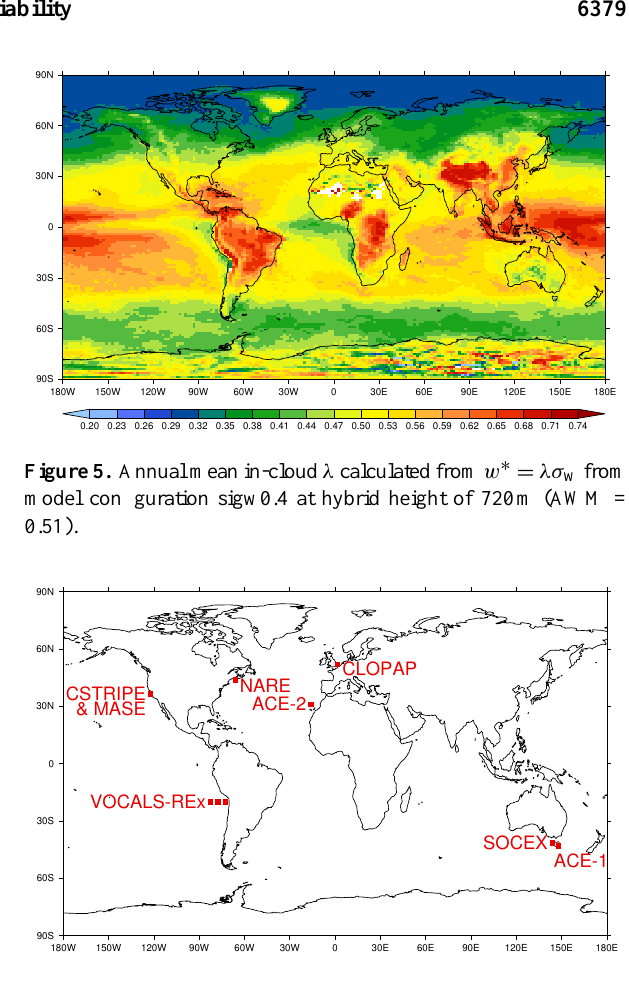
Figure 4. Annual mean in-cloud σ w and CDNC at 720m. Panels Fig. 4 : Annual mean in-cloud σ and CDNC at 720 m. Panels show differences between model w Figure 6. Map of flight campaign locations. Fig. 6 : Map of flight campaign locations. show differences between model configuration TKE_0.1 with re- configuration TKE_0.1 with respect to sigw0.4 for (a) in-cloud σ (AWM = − 0 . 15ms − 1 ) and w spect to sigw0.4 for (a) in-cloud σ w (AWM = − 0 . 15ms − 1 ) and (b) CDNC (AWM = − 12 . 53cm − 3 ). Fig. 6 : Map of flight campaign locations. (b) CDNC (AWM = − 12 . 53cm − 3 ). on the left of each group followed by distributions from each model configuration. In Fig. 7b, published observations 51 of σ w are plotted, followed by distributions from